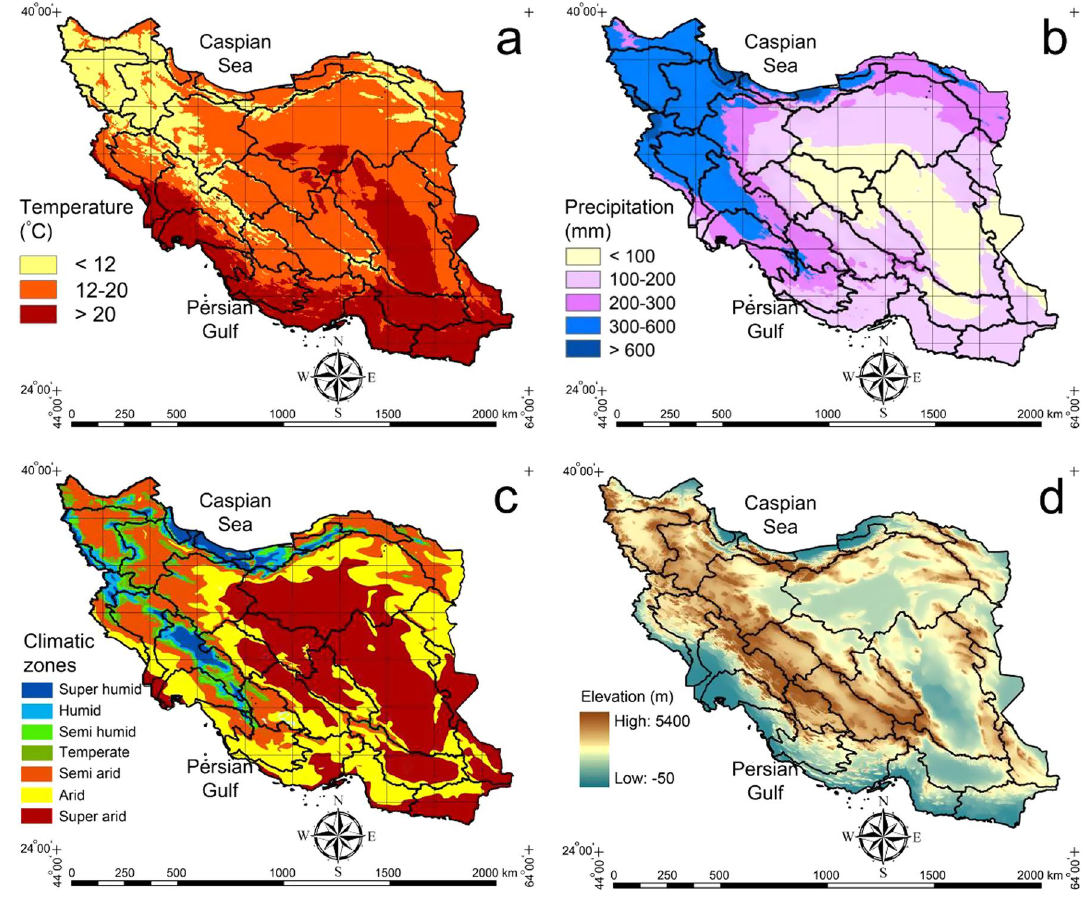
Fig. 2 Input environmental variables to efficiency assessment of the construction of the Qanat water system including a . mean annual tempera- ture, b . mean annual precipitation, c . climatic zones, and d . mean elevation